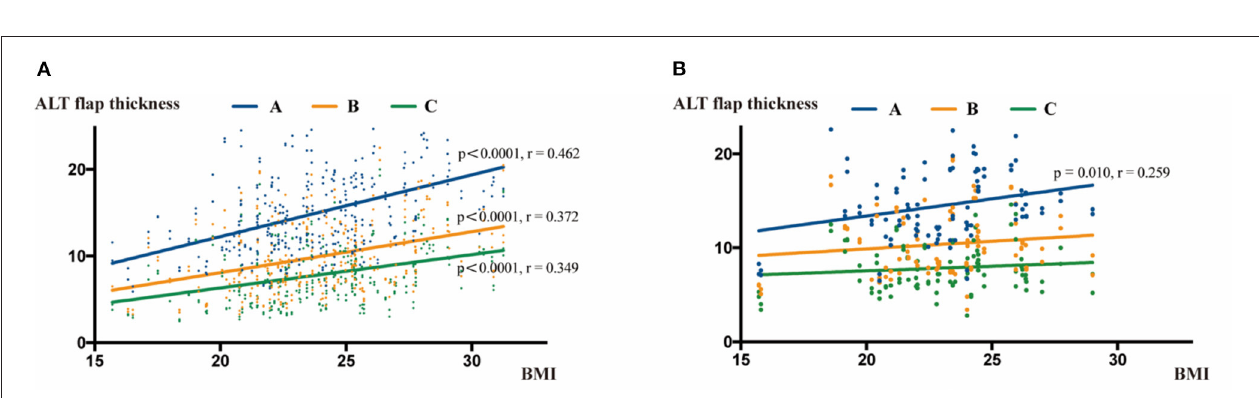
FIGURE 5 | Correlation analysis of ALT flap thickness with BMI. (A) Correlation analysis between BMI and ALT flap thickness measured by CT scans. BMI was positively correlated with the thickness at points A, B, and C. (B) Correlation analysis between BMI and ALT flap thickness measured by ultrasound. BMI was positively correlated with the thickness only at point